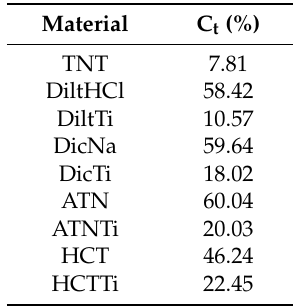
Figure 5. Evolution of ThCW with MCW of TNT, DicNa and DicTi at 50, 100, 150, 200 and 250 MPa compression pressure.